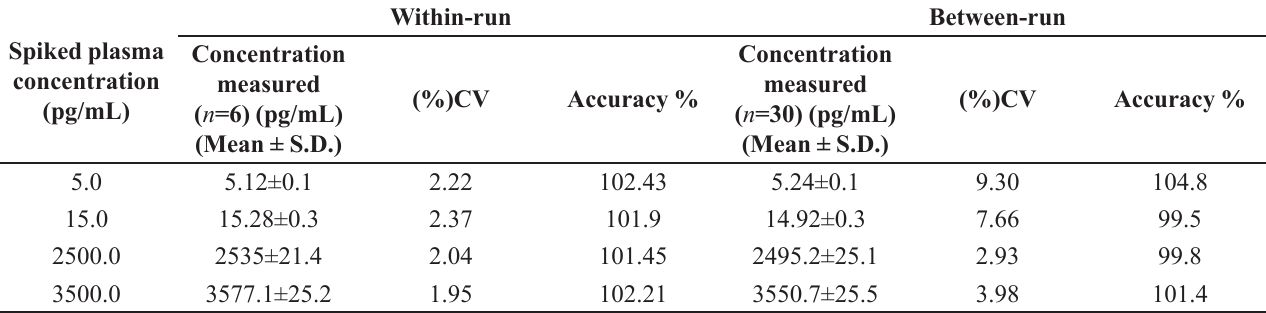
TABLE II - Precision and accuracy (analysis with spiked plasma samples at four different concentrations)